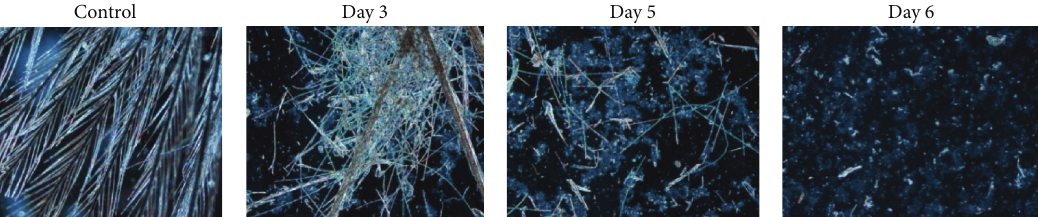
Figure 4: Stages of feather degradation (magnified 40 times).